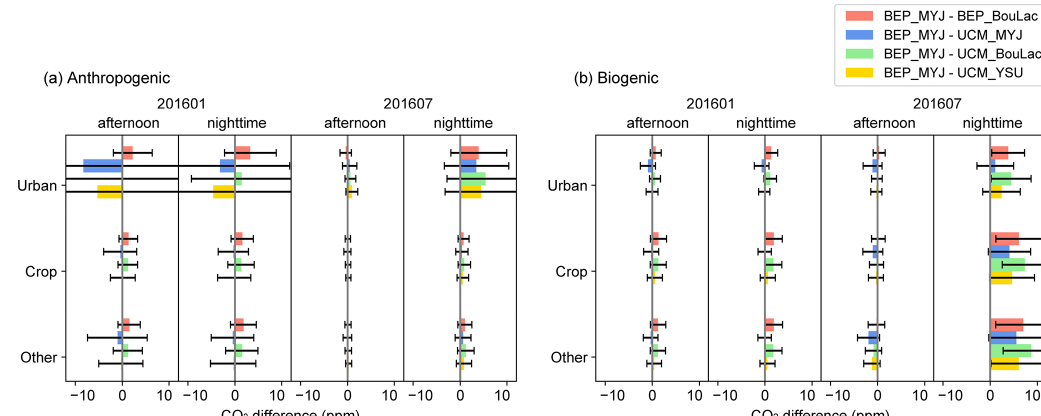
Figure 12. Analysis of the CO 2 difference between the control run (BEP_MYJ) and each of the other four sensitivity runs over two 1-month periods. The colored bars show the monthly mean difference, whereas the black lines indicate ± 1 standard deviation of the monthly values. The results are shown for two periods of the day (afternoon 11:00–16:00UTC, nighttime 00:00–05:00UTC) and for three land use types (urban, crop, and the